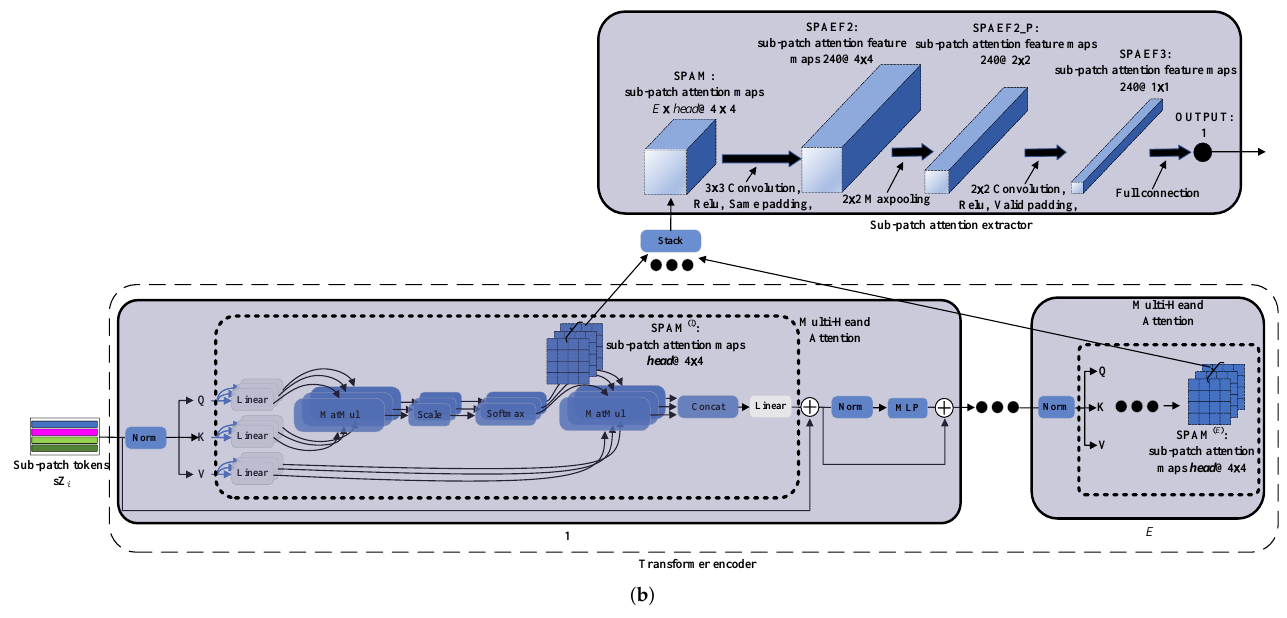
Figure 6. Illustration of the TCSPANet. ( a ) Integrating the SPAE into the trained TCNet, we get the final model TCSPANet. When training, only the SPAE can be updated. ( b ) Structure of SPAE. (2) Structure of the SPAE: The structure of the SPAE is shown in Figure 6b, which